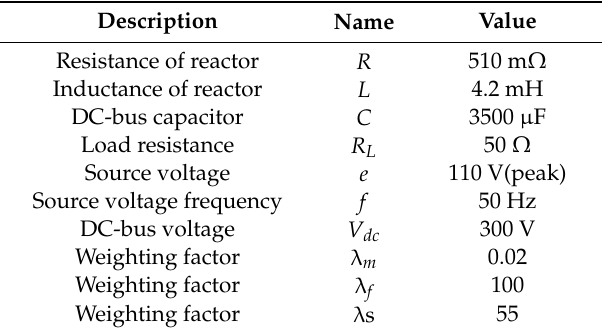
Table 1. Electrical Parameter of Simulation.